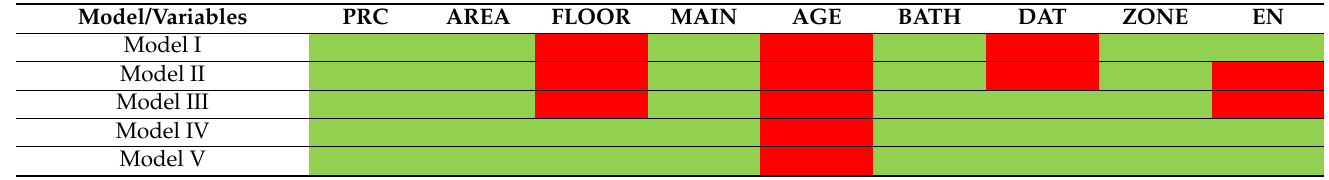
Table 4. Variables selected (green) or excluded (red) by EPR-MOGA for each model. Model/Variables PRC AREA FLOOR MAIN AGE BATH DAT ZONE